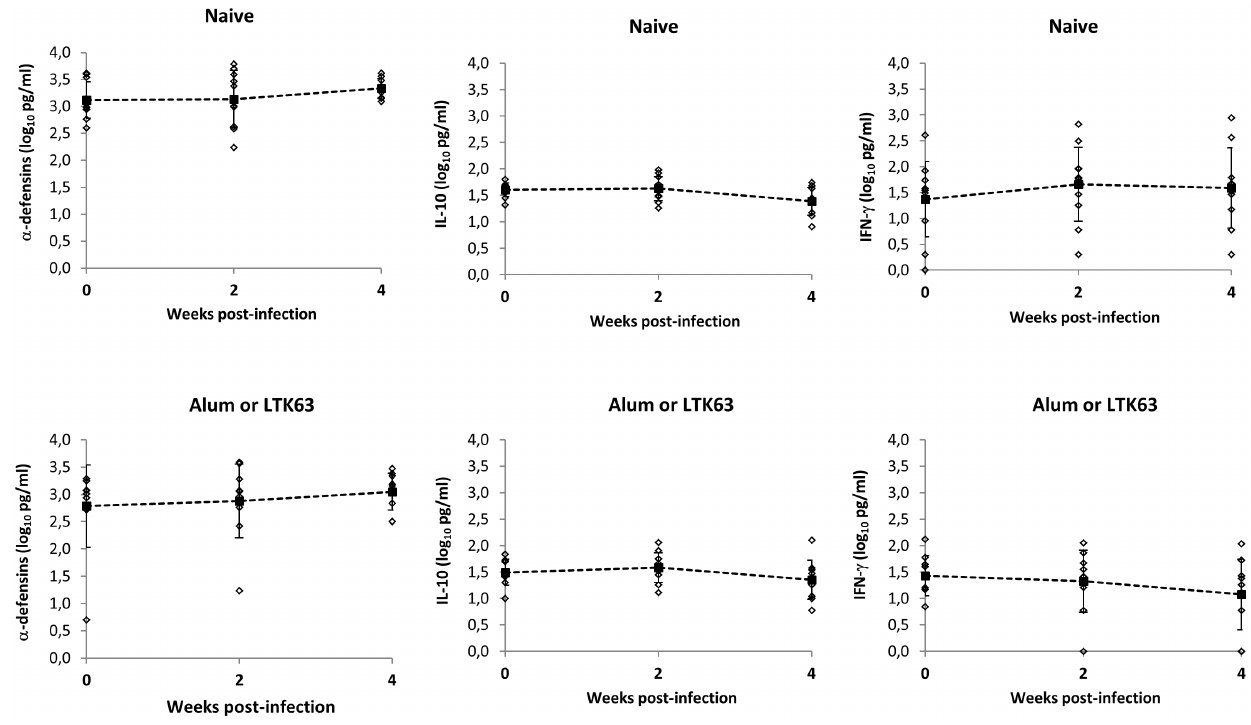
Figure 2. Plasma a -defensin, IL-10 and IFN- c levels with respect to the pre-infection values in naı¨ve (n=11) and adjuvant treated monkeys (n=10) inoculated with SHIV SF162P4cy . No significant differences were observed between naive and adjuvant treated monkeys during the observation period. Mean values with standard deviations are connected by dotted lines.